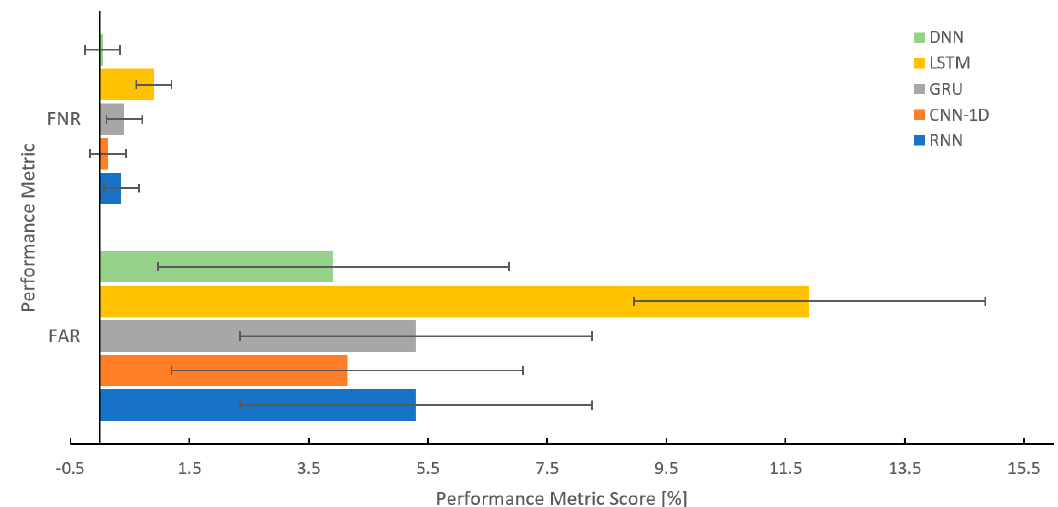
Figure 6. Performance of different DL-based IDS schemes in terms of FAR and FNR .